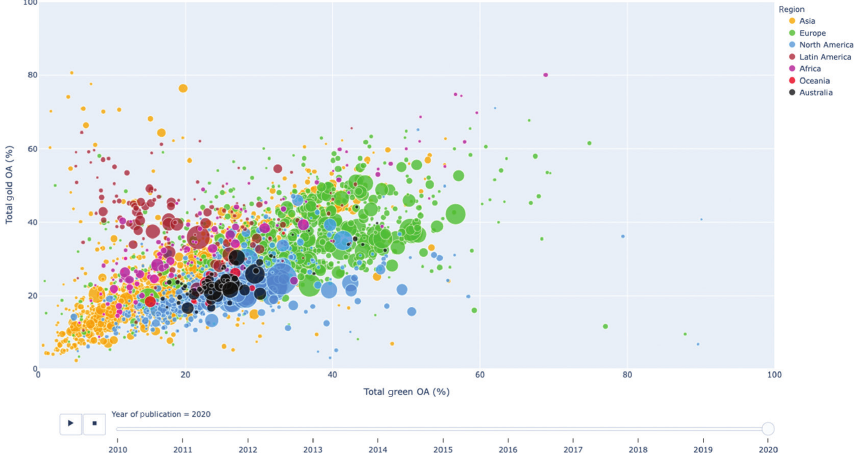
Fig. 2: Publisher-mediated OA (Gold) vs. repository-mediated OA (Green) by institution for 2020. Each point plotted is a university, with size indicating the number of outputs. Colour indicates the region. Data sources: Crossref, Unpaywall, Microsoft Academic. Analysis: Curtin Open Knowledge